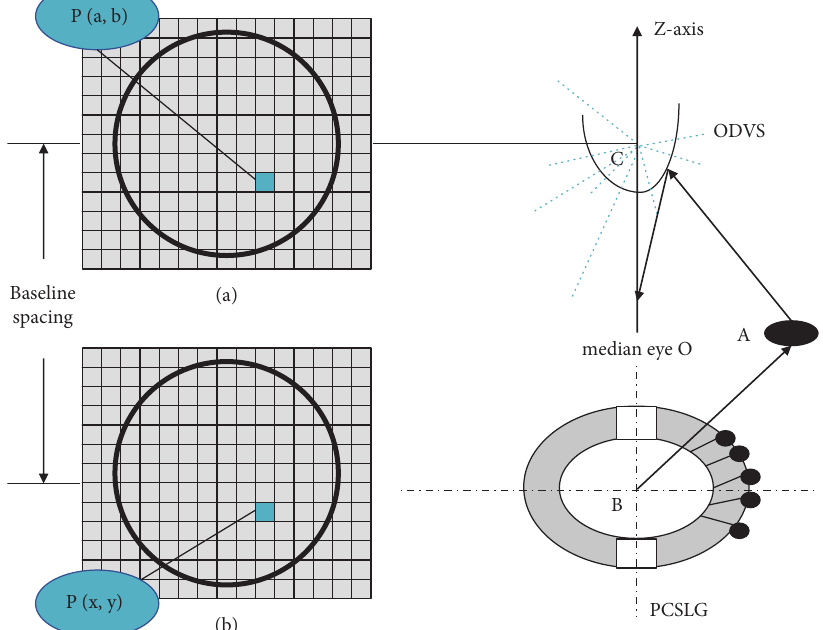
Figure 1: Active stereo panoramic vision sensor model. O O v —single view of omnidirectional vision sensor (ODVS); p —single reflection point of panoramic color structured light generator (PCSLG); baseline distance—the distance between a single viewpoint O v and a single emission point O p ; central eye O-midpoint of baseline distance; A—a certain object point in space. The positions of a and b determine the incident angle, the color of P (a, b) determines the projection angle, the position of x and y determines the incident angle, and the color of P ( x , y ) determines the actual color of the object point in space. Figure 1(a) shows a schematic diagram of the image ON the panoramic vision sensor when the power supply of the color panoramic projection light source is ON. Figure 1(b) presents the image schematic on a panoramic vision sensor when the power of the color panoramic projection light source is OFF.